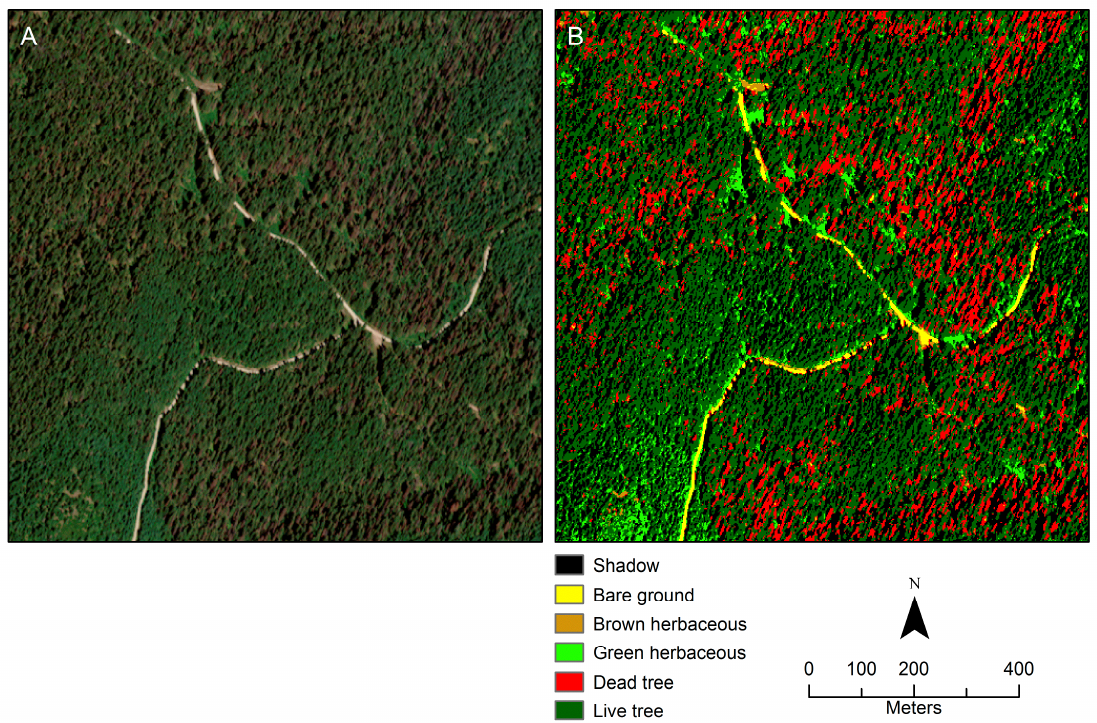
Figure 3. Comparison of true-color WorldView-2 (WV2) imagery ( A , 1 September 2018 image) and the classification ( B ).